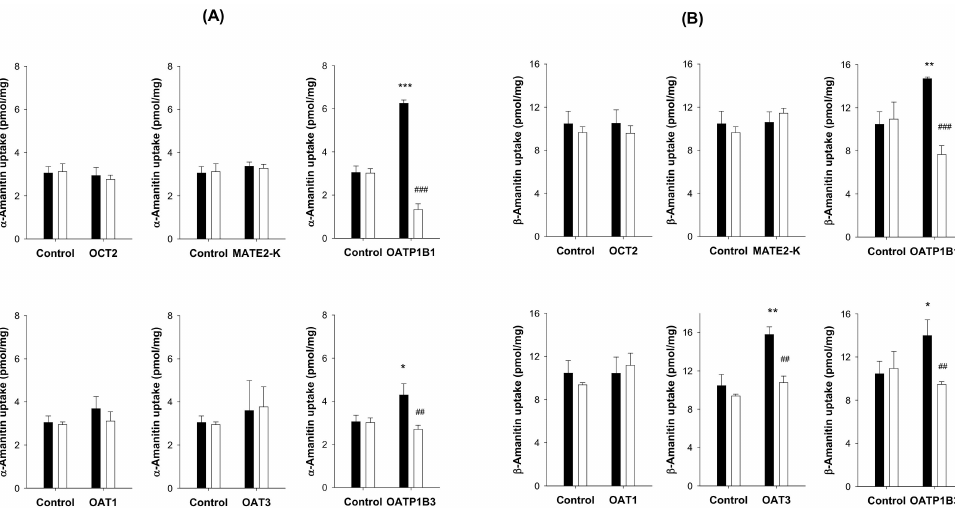
Figure 6. Uptake of ( A ) α -amanitin (50 µ M) and ( B ) β -amanitin (50 µ M) into HEK293 cells expressing renal transporters, such as OCT2, MATE2-K, OAT1, and OAT3, and hepatic transporters such as OATP1B1 nd OATP1B3 transporters, respectively, was compared with uptake into HEK293